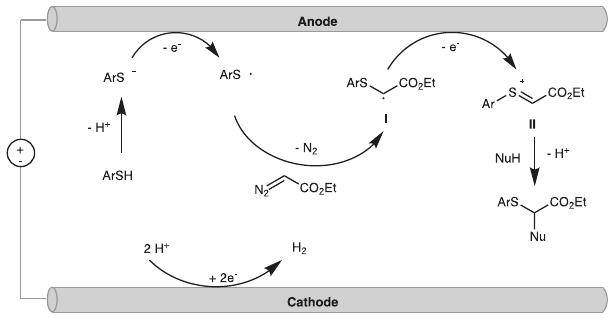
Fig. 5 | Proposed reaction mechanism. Electrochemical oxidative difunctionali- zation of